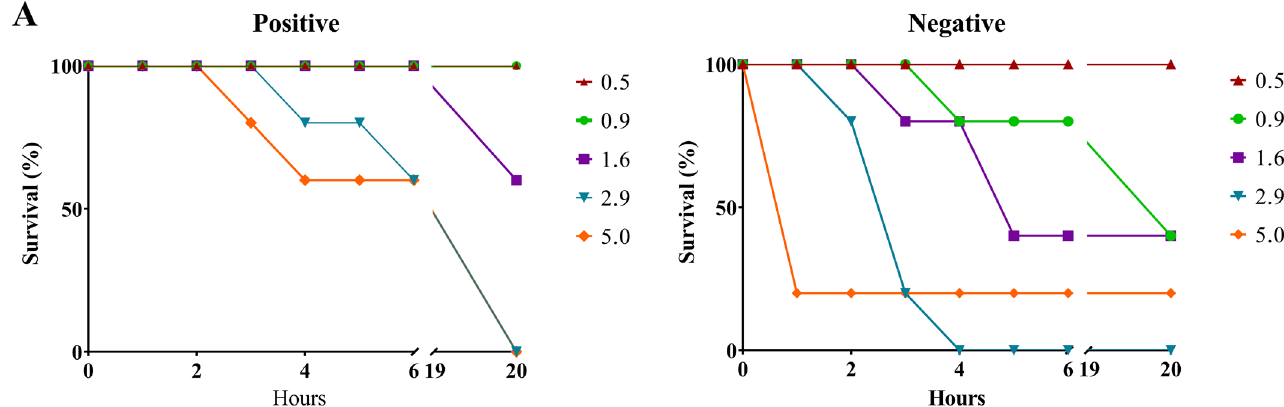
Figure 8. Lethal dose of venom pools from C. durissus . Survival of mice of different groups according to time to death after injection of (A) crotamine-positive and (B) crotamine-negative venom pools. Different colors represent different doses (µg venom/animal).